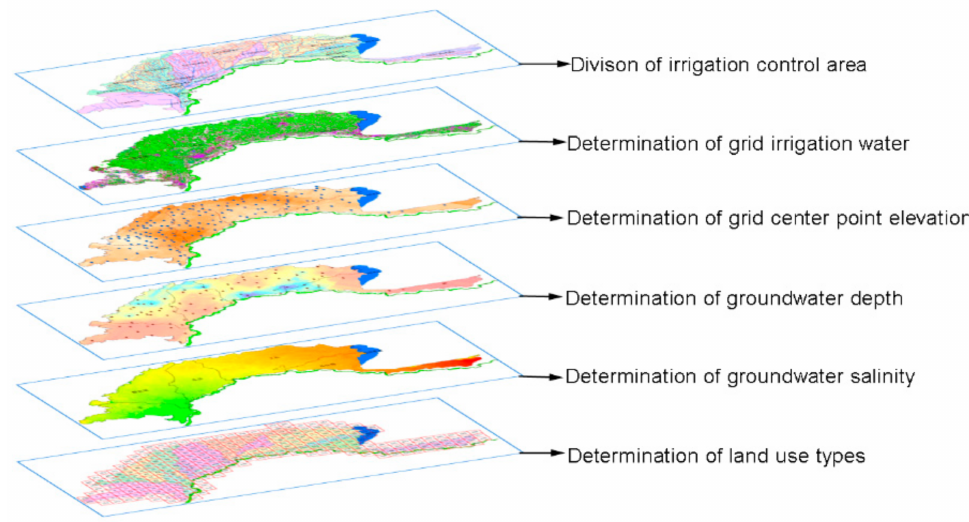
Figure 3. Input data extraction map of grid center points in the study area.